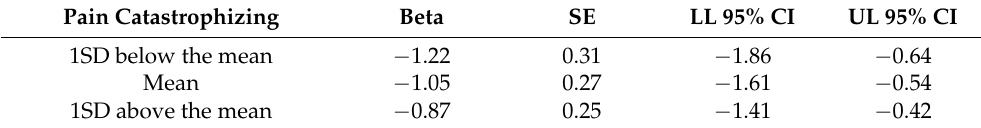
Table 3. Indirect conditional effect at specific levels of the moderator when treating pain severity as a mediator. Pain